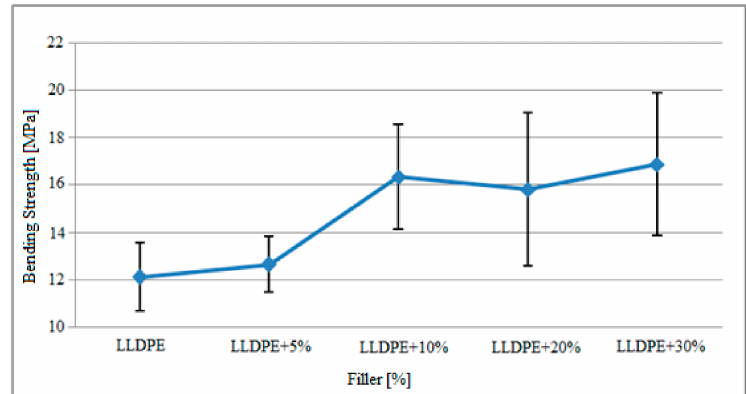
Figure 6. Variation in bending strength of polyethylene matrix specimens after gamma radiation based on the filler